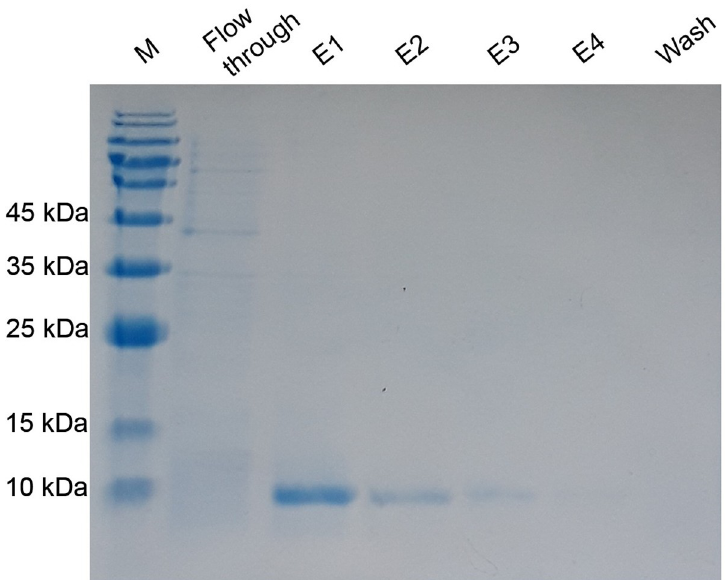
Fig 4. The purification of the rPF4 protein produced by the cytoplasmic expression system. E1 through E4 correspond to the cytoplasmic rPF4 proteins purified in 0.5 mL elution fractions. To avoid contamination with unwanted proteins, the matrix was washed three times with the wash buffer containing 10 mM of imidazole. M denotes the molecular weight marker.